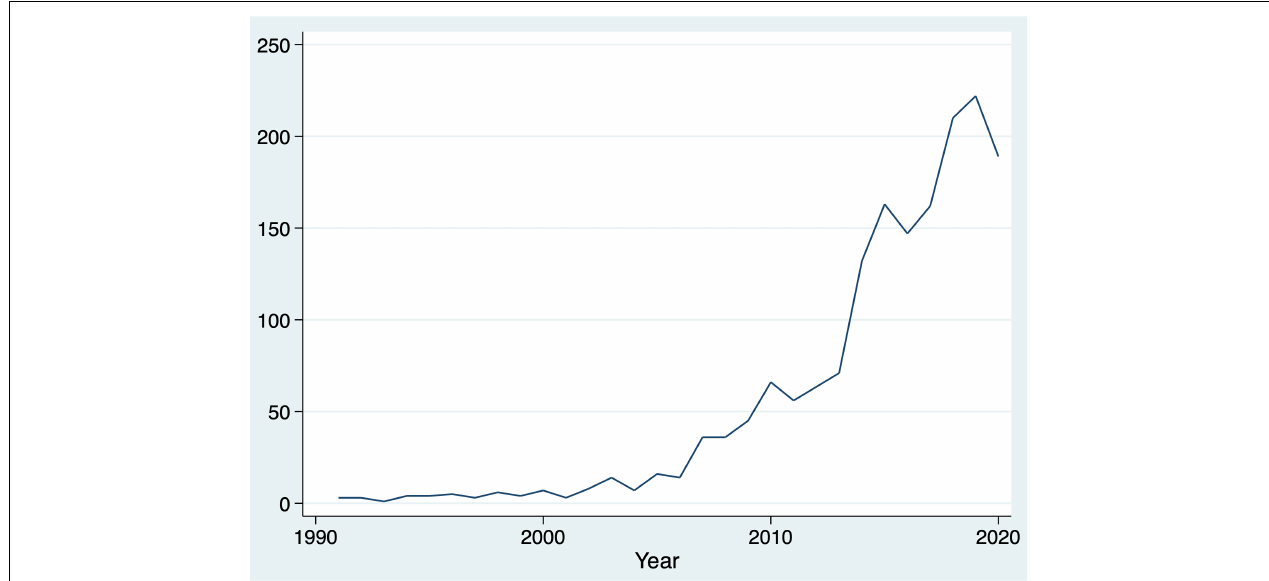
FIGURE 1 | Number of publications per